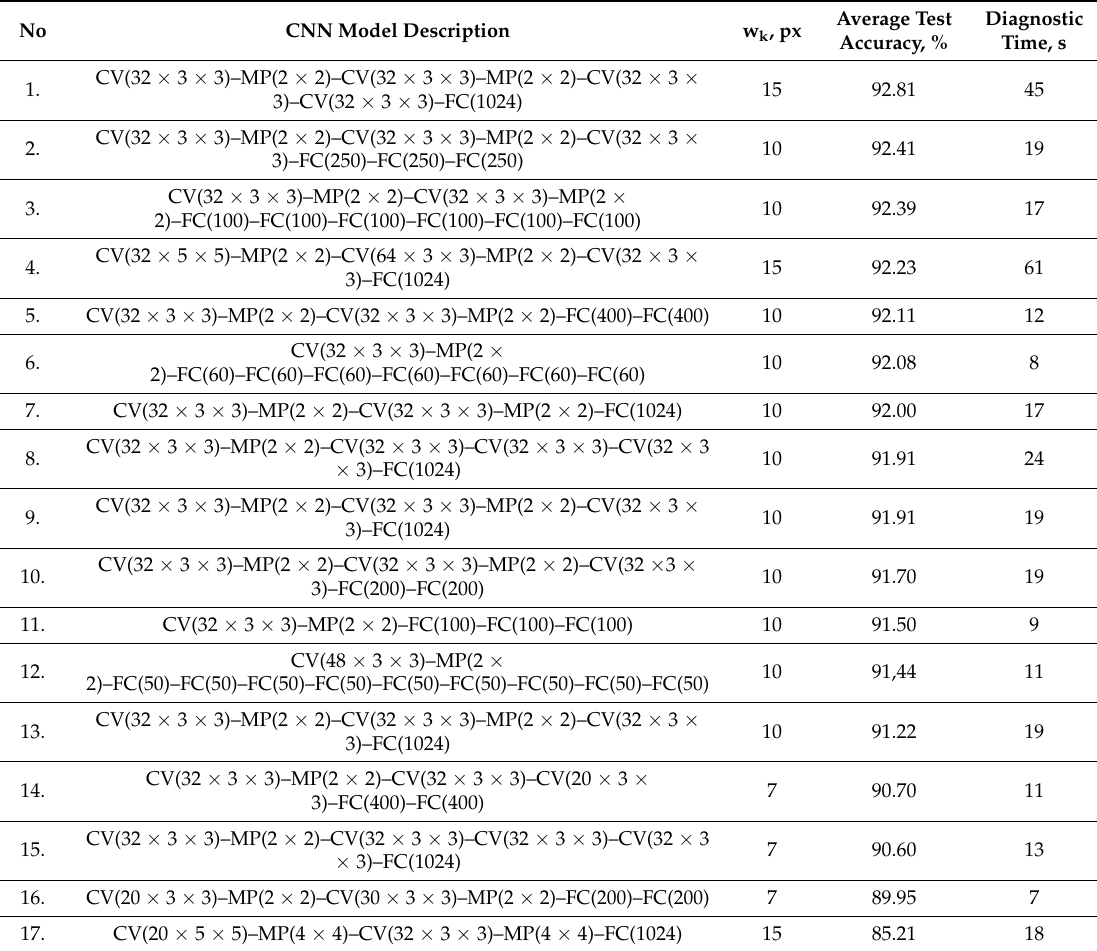
Table 1. Structure and characteristics of the investigated neural networks. CV—convolutional layers (the brackets indicate the number of feature maps and the size of the kernels), MP—max-pooling layers (the brackets show the size of the pooling window), FC—fully connected layers (the brackets indicate the number of